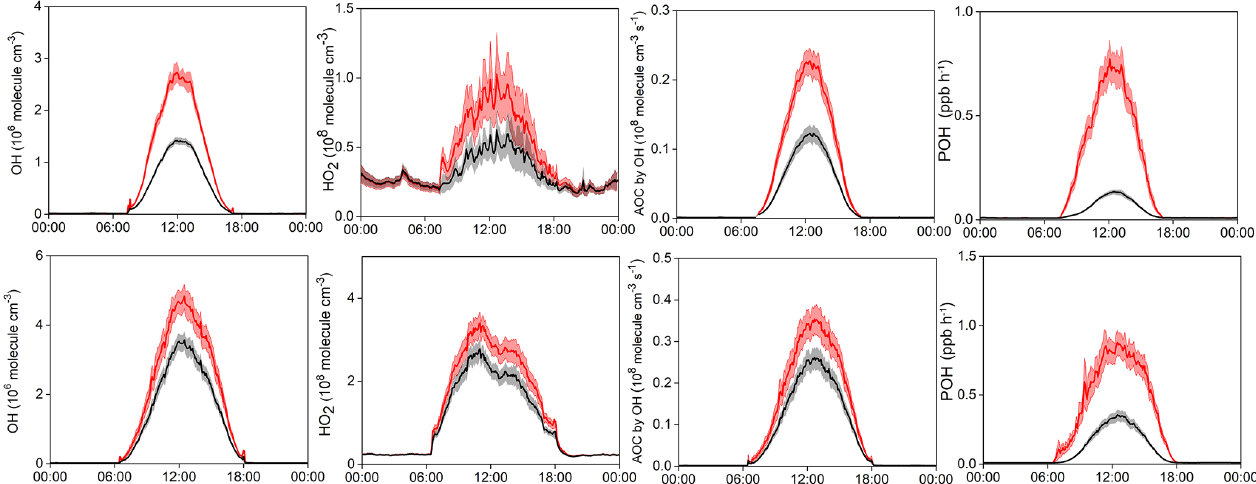
Figure 8. Model-simulated average diurnal variations of OH, HO 2 , AOC, and primary OH production rate (P OH ) at Mt. Tai in winter (upper panel) and spring (lower panel), with (red) and without (black) constraints of HONO measurement data. Note that the model only considers the homogenous HONO formation from OH + NO reactions. Shaded area indicates the standard